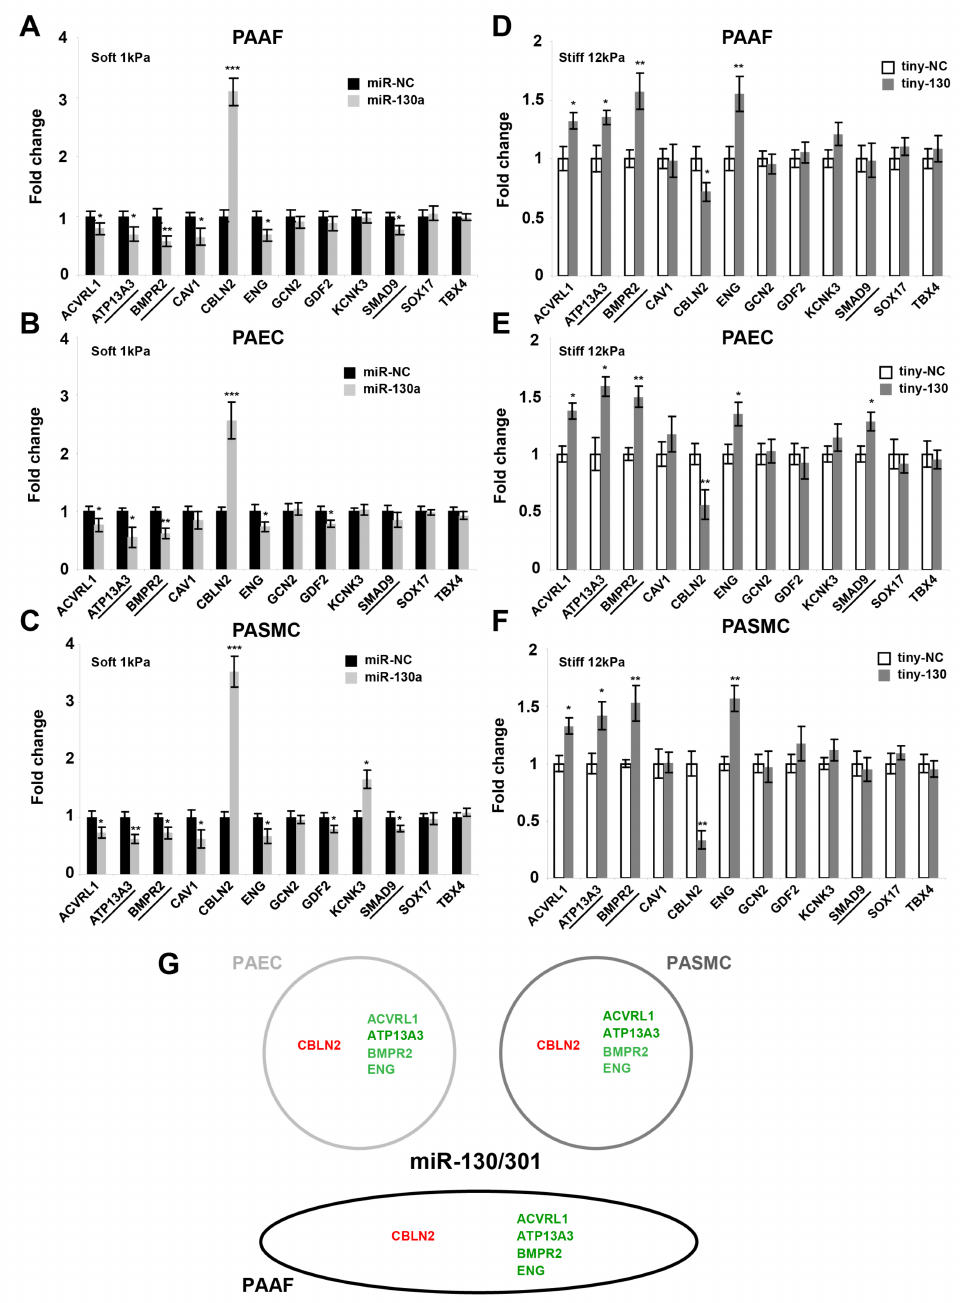
Figure 3. The miR-130/301 family modulates the expression of factors genetically associated with PAH. Following transfection with the indicated miR-130a mimic ( A – C ), miR-130/301 inhibitor (tiny-130) ( D – F ), or related scrambled controls, transcript levels of factors genetically associated with PAH were analyzed by RT-qPCR in PAAFs, PAECs, and PASMCs. Underlined genes: Predicted targets of miR-130/301 members (TargetScan). Mean expression in control groups (si-NC) was assigned a fold change of 1, to which relevant samples were compared. Data are expressed as mean ± SD (* p < 0.05, ** p < 0.01, *** p < 0.001) of three independent experiments. Paired samples were compared using a 2-tailed Student’s t -test. ( G ) Schematic of the main results. Red: upregulated genes. Green: downregulated genes, upon miR-130a forced